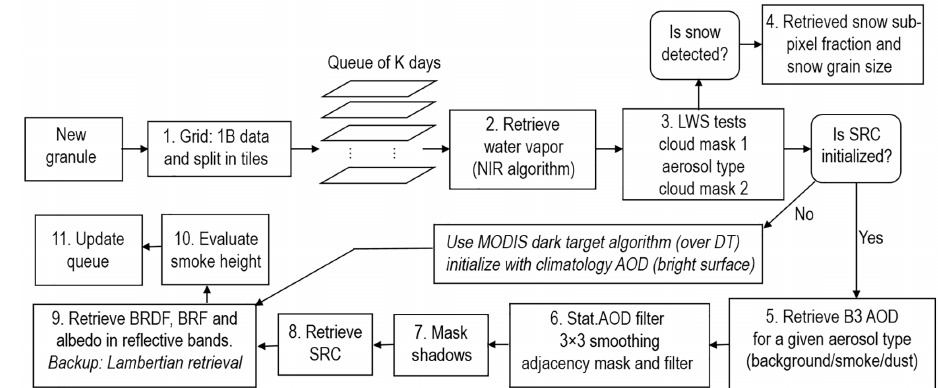
Figure 1. Block diagram of MAIAC